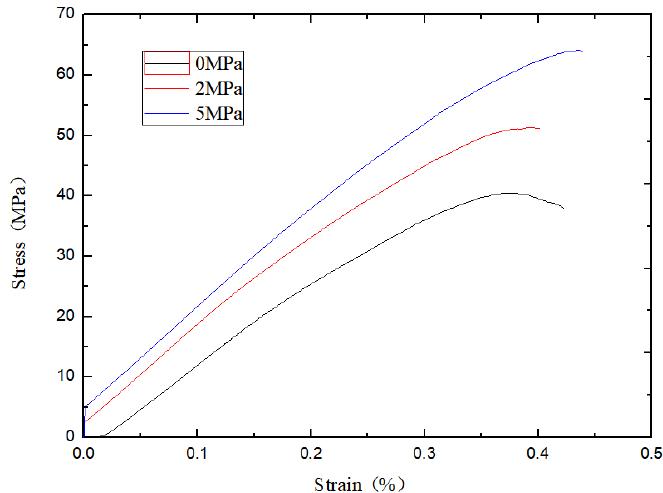
Figure 10. Numerical simulation triaxial experiment.